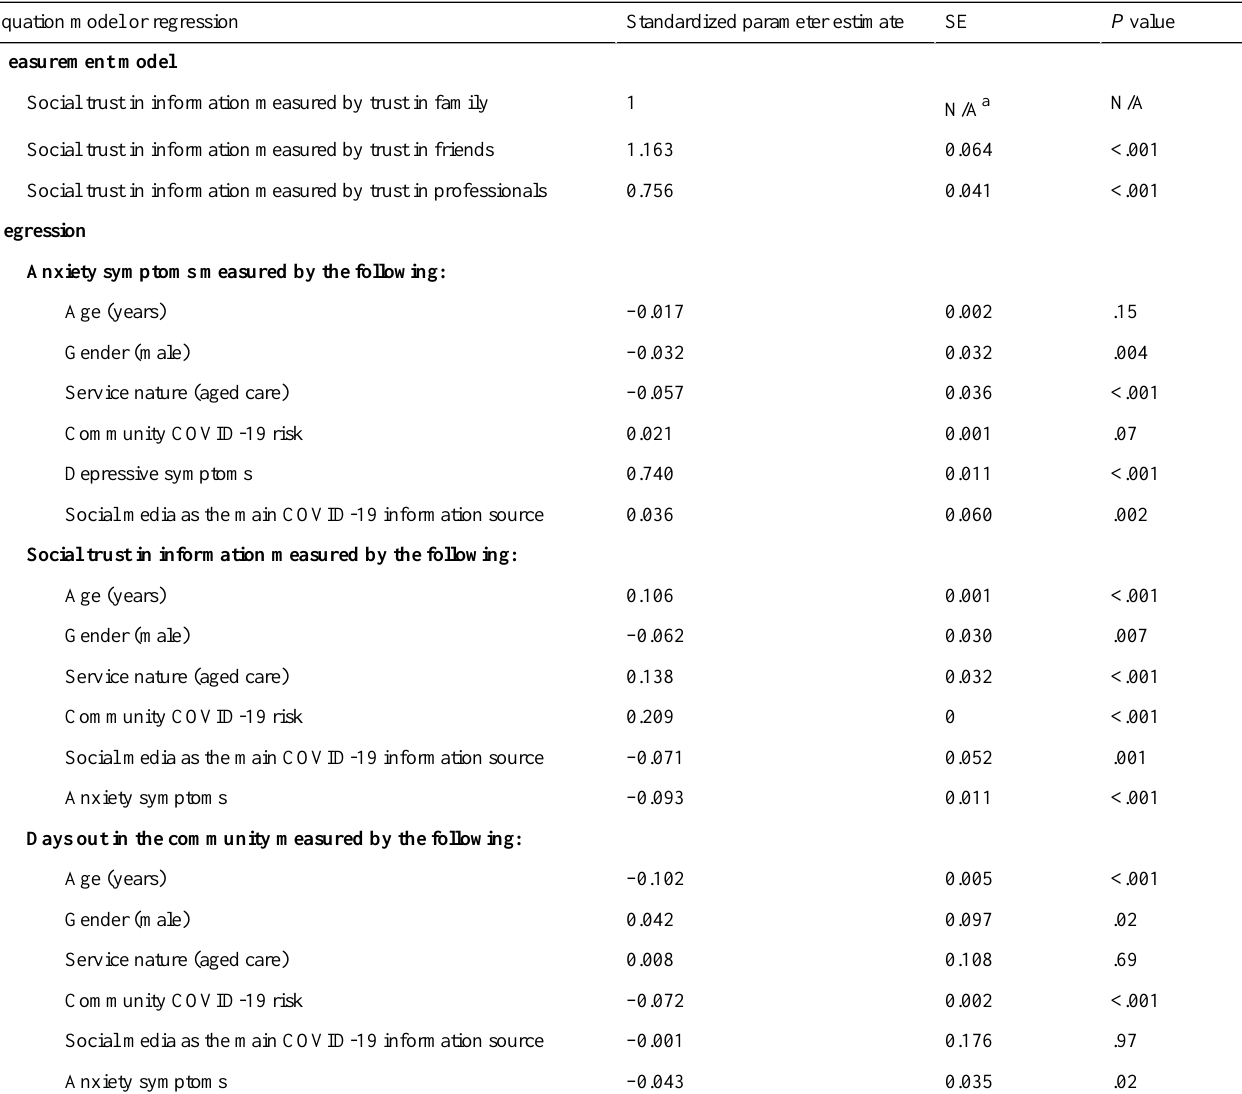
Table 3. Standardized parameter estimates and their standard errors of structural equation modeling (N=3415) treated with full information maximum likelihood